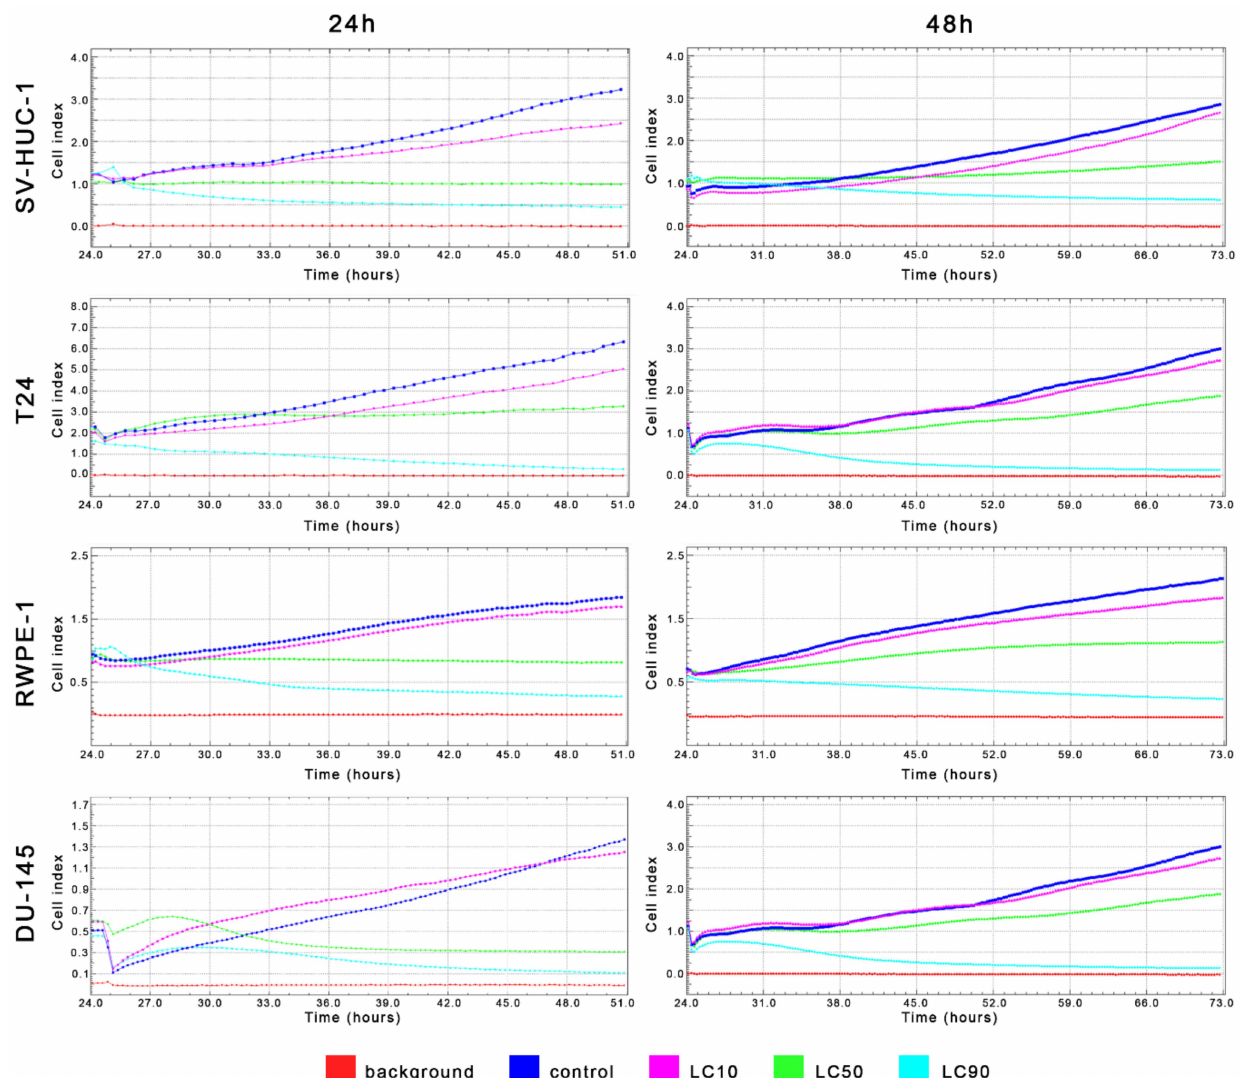
Figure 4. Real-time cell growth analysis of bladder and prostate cell lines after ciprofloxacin treatment. Data were measured every 30 min for 24 or 48 h. Obtained results confirmed that LC values calculated using MTT assay actually cause a reduction of cells viability by 10%, 50%, and 90%. SV-HUC-1—non-malignant human urothelium; T24—human bladder cancer; DU-145—human prostate cancer; RWPE-1—non-malignant human prostate